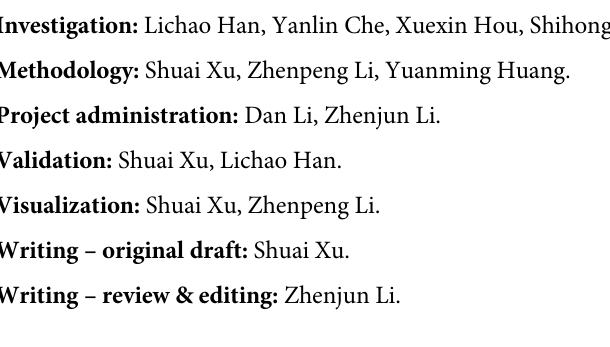
S2 Fig. Distribution of functional categories in the Nocardia unique genome. Genes with “Function unknown” were not included. S3 Fig. Distribution of functional categories for all group core genomes. (A) Functional cat- egories for core gene families in each phylogroup. (B) The number of core gene families in each phylogroup. S4 Fig. Phylogenomic tree across 203 Nocardia strains. A maximum likelihood phylogenetic tree was constructed based on the concatenation of 241 single-copy genes of 81 type strains and 122 additional genomes of Nocardia spp. with 1000 bootstrap replicates using Rhodococcus globerulus NBRC 14531 as an outgroup. Bootstrap values are indicated on the nodes. Phyloge- netic groups are highlighted in different colors. Red boxes indicate the same species has a type strain in different subgroup. The asterisk represents clusters lacking a type strain. S5 Fig. Phylogenetic tree of type strains of Nocardia based on the sequences of five com- monly used markers. Phylogenetic tree was constructed by the maximum likelihood method based on the five concatenated gene sequences ( gyrB , 16S , secA1 , hsp65 , and rpoB ) of 81 Nocar- dia type strains using Rhodococcus globerulus NBRC 14531 as an outgroup. Bootstrapping was carried out using 1000 replicates and values are shown at the